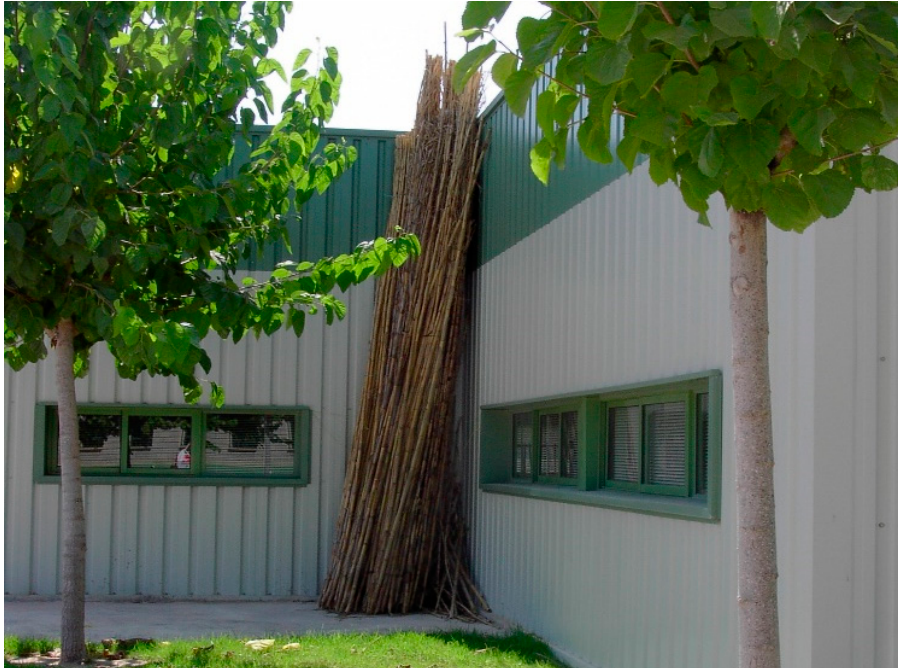
Figure 1. Giant reed left outside for 12 months for air drying.